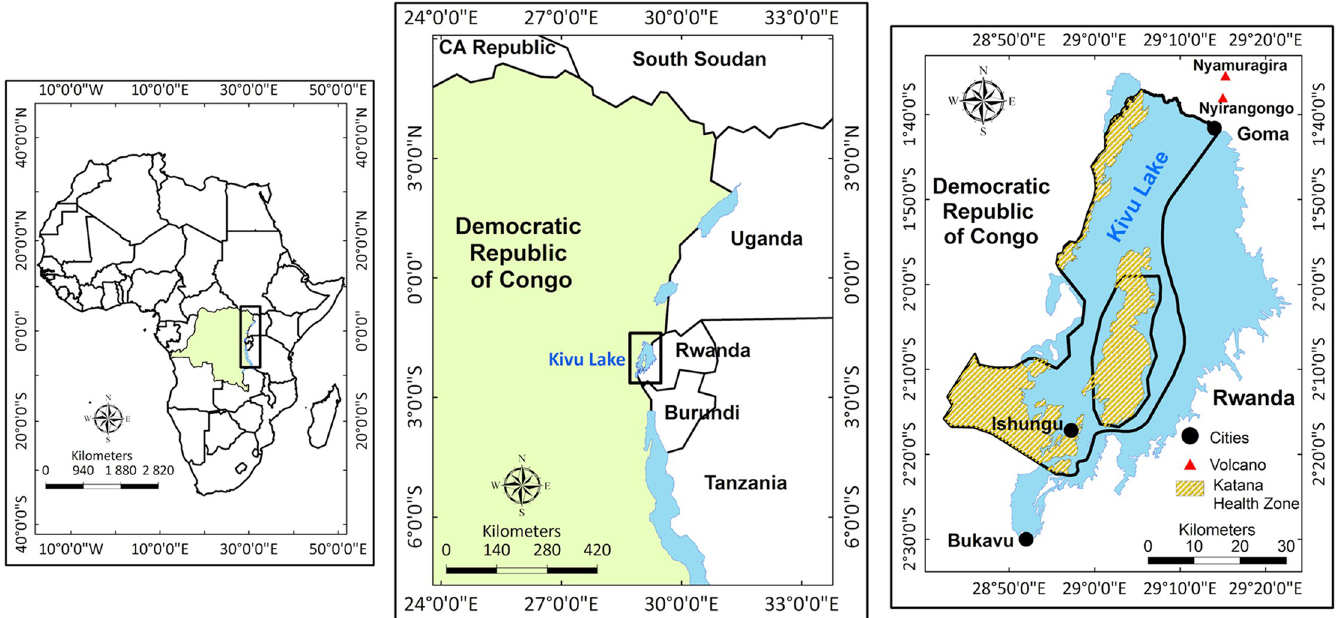
Fig 1. Map of the Katana health zone bordered by Kivu Lake, the two large active volcanoes in the area are shown (right) and other Lakes in the African Rift Valley (middle). This map was created using QGIS version 2.18